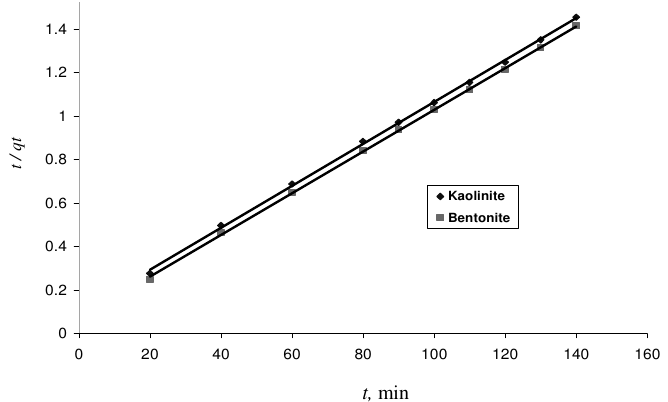
Figure 8. Time profile and pseudo second order kinetics model for nickel(II)